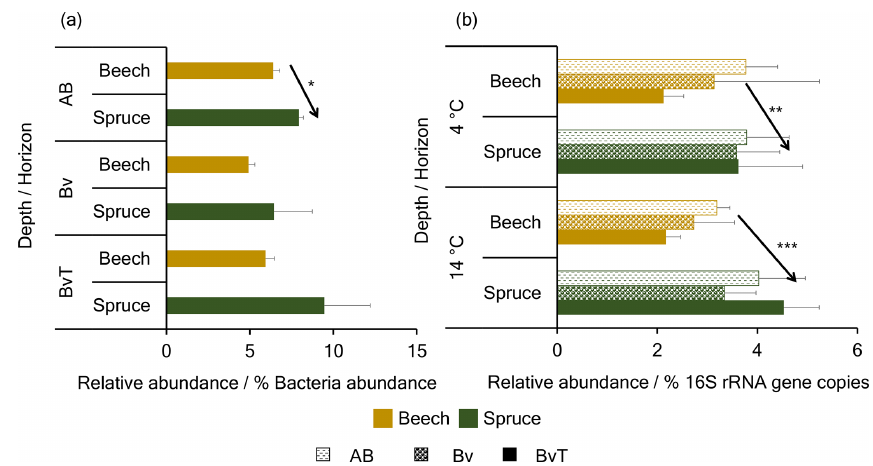
Figure 6. Relative abundance of RuBisCO genes in the beech and spruce soil. Shown are the relative abundances of (a) predicted and (b) quantified RuBisCO genes coding for the CBB pathway in the beech and spruce soil. Data in (a) are based on predictions by PICRUSt2 analysis of bacterial 16S rRNA gene amplicon sequence data for the beech and spruce bulk soil, while data in (b) are acquired by qPCR of cbbL IC genes for both soils incubated at 4 and 14 ◦ C. *, **, and *** denote p < 0 . 05, p < 0 . 01, and p < 0 . 001,